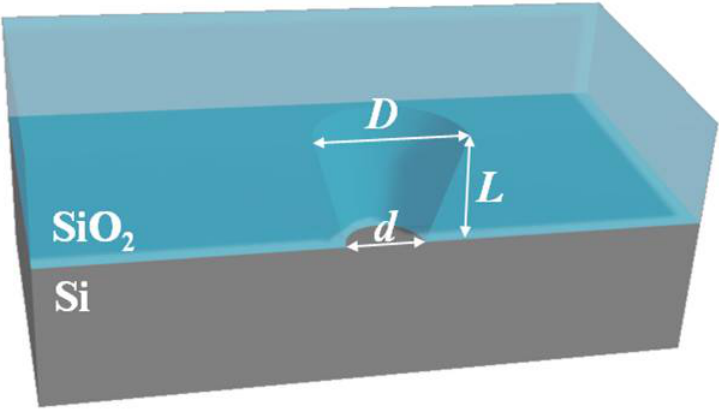
/Si template (upper diameter D , lower diameter 2